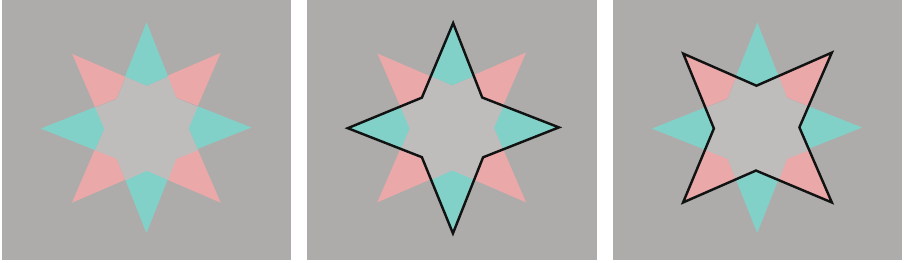
Figure 4. Examples of completion of the uncolored patches in non-afterimage stimuli. (Left) Staring at this image for a while (~10 s) causes the scene to decompose into a red and green star. The central grey area is then perceived as having both a red and green color. When one of the stars disappears due to adaptation, the other star is clearly perceived as having one continuous color. (Middle, and Right) Presenting a boundary around one of the stars may speed up the process of image segmentation. Note, that this stimulus is shown close to equiluminance to allow for the disappearance of one of the stars due to adaptation, but the color completion will occur even when the background is white (as in the original van Lier et al .